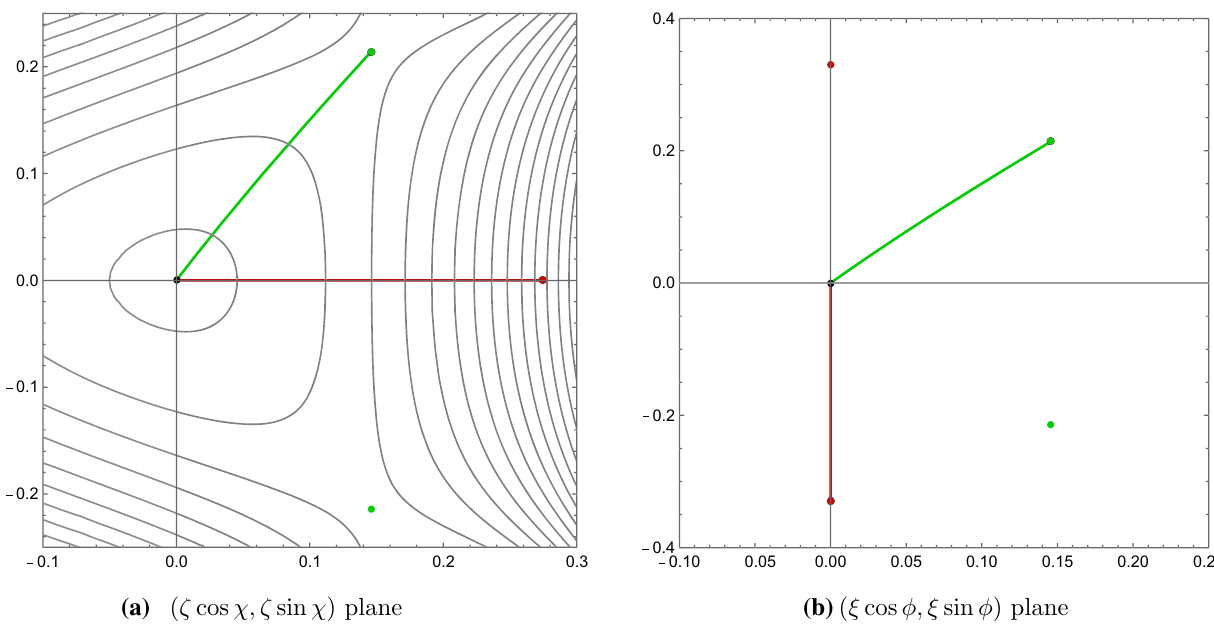
Fig. 1 SO ( 8 )/ SO ( 8 ) Janus solutions that flow to G 2 and U ( 3 ) critical points are given respectively by green and red lines on the contour plot of the superpotential. The two green and red dots represent equivalent G 2 and U ( 3 ) critical